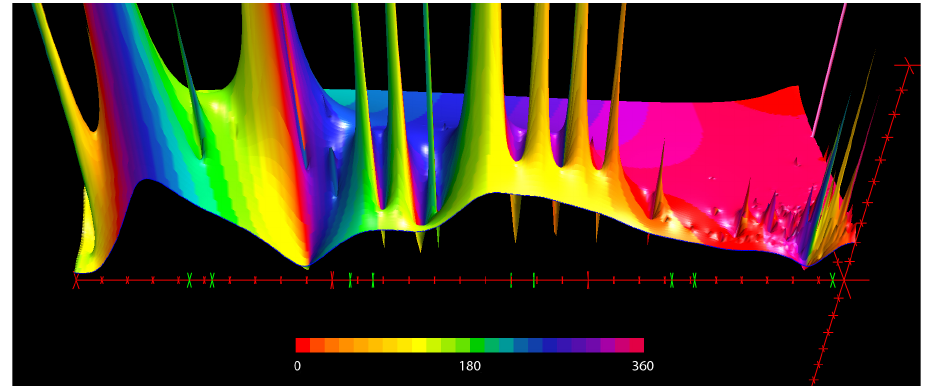
Figure 5. Response function amplitude on the west side of Ungava Bay plotted as a function of complex angular velocity. The colours denote complex phase, in degrees, as denoted on the scale below the main figure. Values at real values of angular velocity are plotted in blue. The origin (0,0) is on the right with the positive real axis (in red) running from right to left and the negative imaginary axis running into the figure. Both are marked by red crosses every 1 rad/day. The vertical axis is marked similarly at unit intervals. On the real axis green crosses indicate the limits of the tidal bands near 2 π (diurnal), 4 π (semi-diurnal), 6 π and 8 π rad / day .